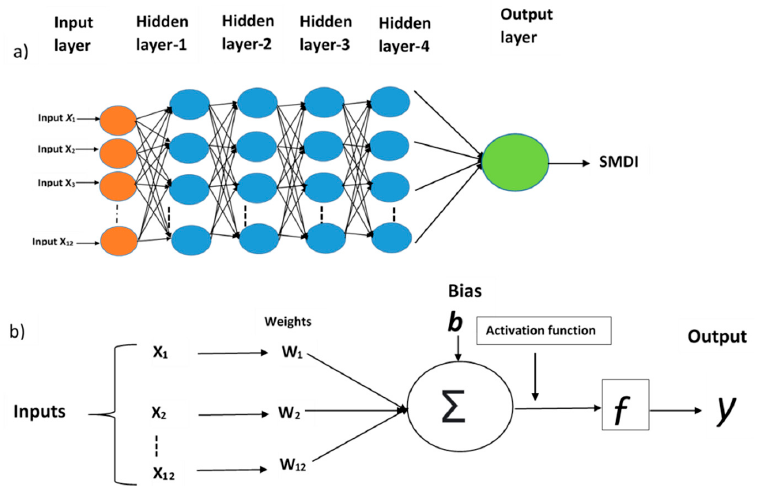
Figure A1. An architecture of the DFNN model used in this study with one input layer, four hidden layer, and one output layer connected with neurons ( a ). The output is achieved by the linear sum through non-linear activation function (RectifierWithdropout) passing by the layers with neurons where each neurons receive one or more input signal ( b